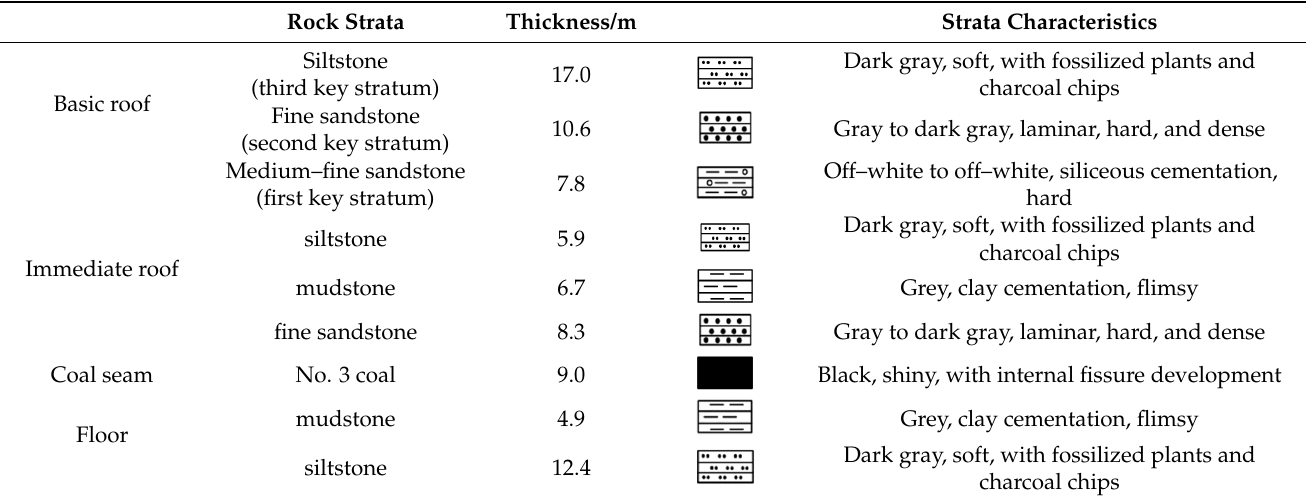
Table 1. Strata description of the 6302 working face.